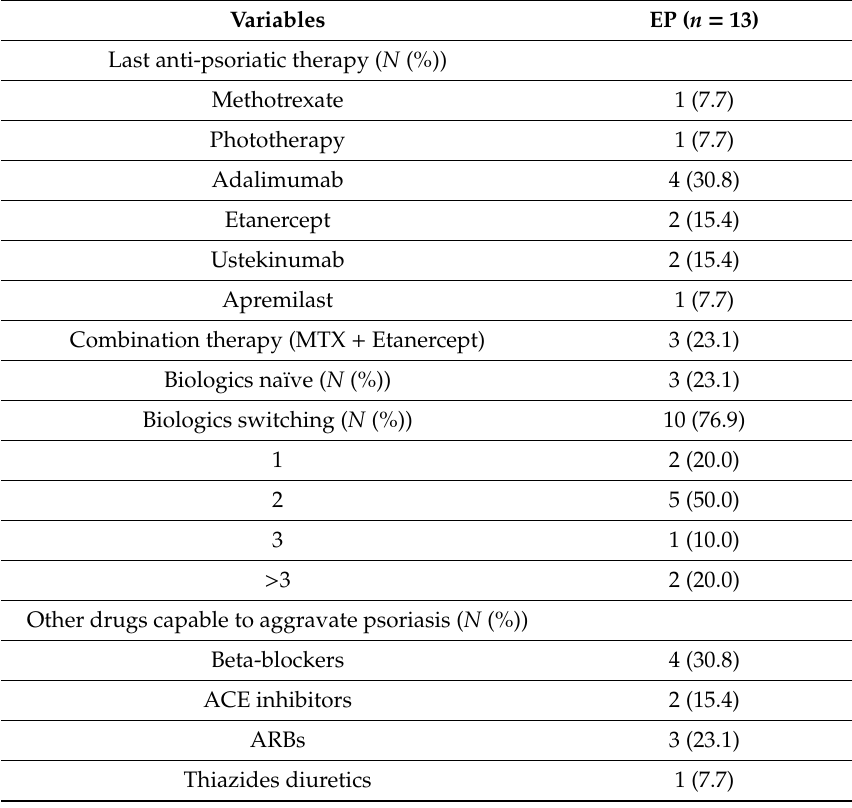
Table 1. Pharmacological history in our